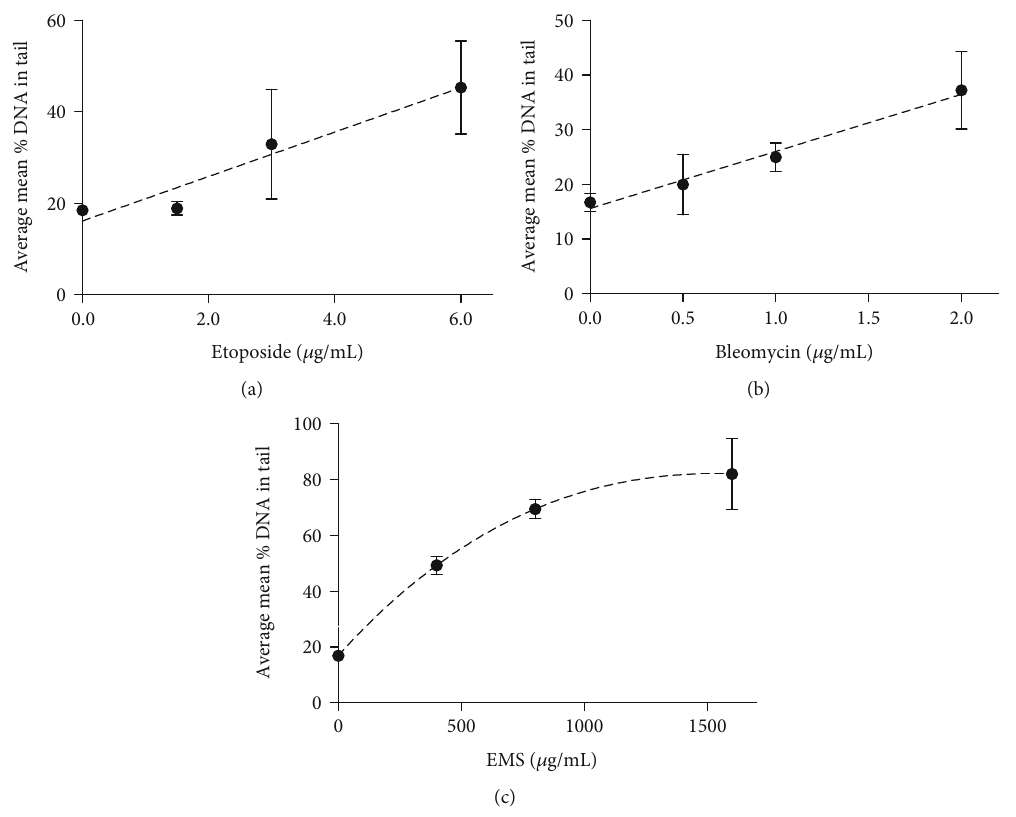
Figure 3: Comet assay — comparison of treatment by (a) etoposide, (b) bleomycin, and (c) EMS. The data are plotted as the average of the means of 3 separate comet assay replicates performed in parallel on the same set of treated samples. Statistical analysis is given in Table